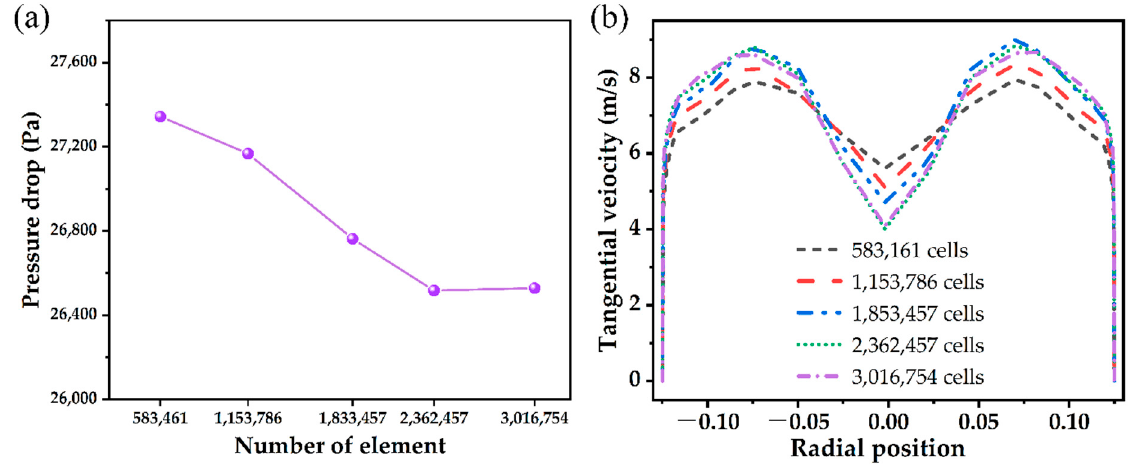
Figure 4. Grid independence verification for ( a ) pressure drop verification and ( b ) tangential veloc- ity verification.